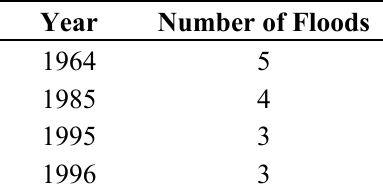
Table 2. Number of floods in specified year for DHF